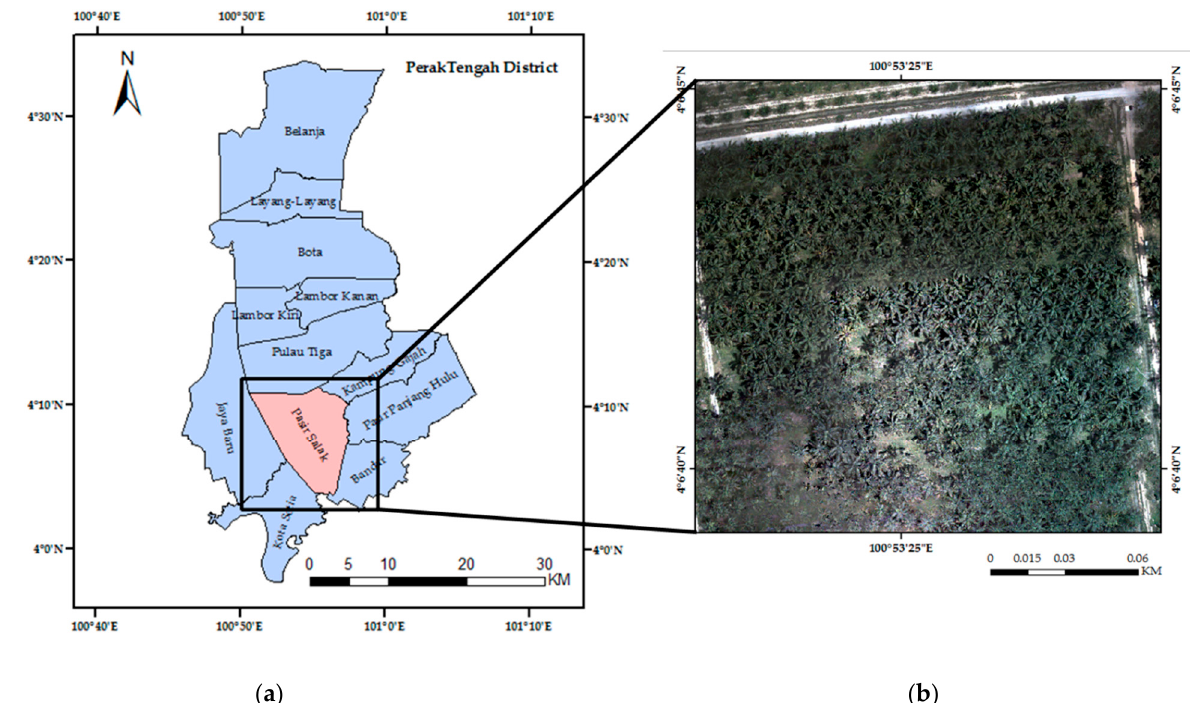
Figure 1. The Perak Tengah district, Perak, ( a ) Mukim Pasir Salak, ( b ) the image of the study area. The sample selection of oil palm trees with non-infected and infected by G. boninense is random based on census obtained from Malaysian Palm Oil Board (MPOB).